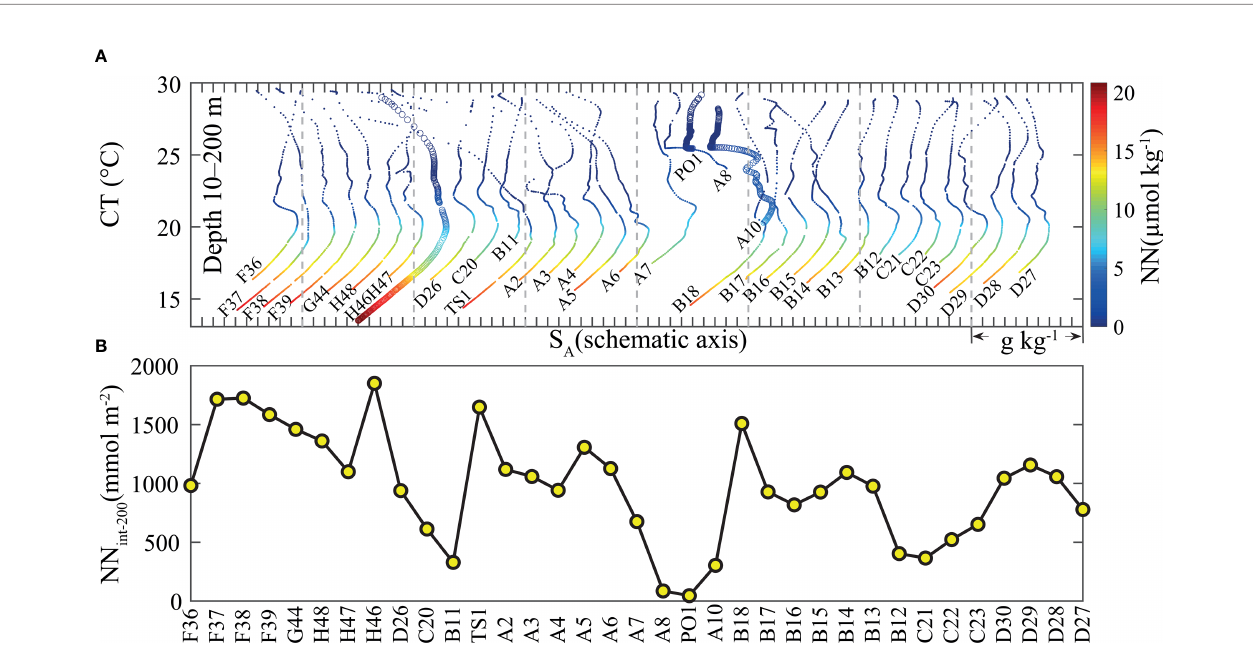
FIGURE 2 | (A) Cascade T-S diagram (from 10 to 200 m, D S A = 0.2 g kg -1 ) for all sampling stations, where the background color indicates the nitrate + nitrite (NN, µmol kg -1 ) concentration. The pro fi les of stations H46, PO1, and A10 are highlighted with circular markers. (B) Depth-integrated NN between the surface and 200 m (NN int-200 , mmol m -2 ) of pro fi les interpolated by the PCHIP